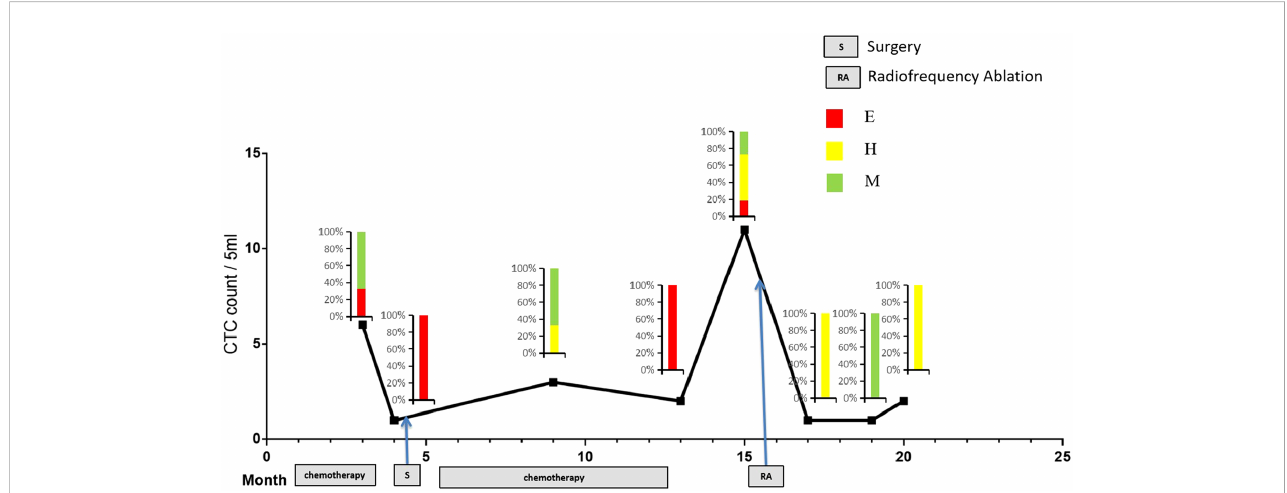
FIGURE 7 Longitudinal monitoring of ETM CTCs in patients. Plot of CTC counts per 5 ml of blood based on Canpatrol platform in a patient who was serially sampled during treatment with neoadjuvant chemotherapy, followed by surgery and adjuvant chemotherapy. Color-coded quantitation of EMT features is shown above each time point. Each experiment was repeated for three times, and each group had four